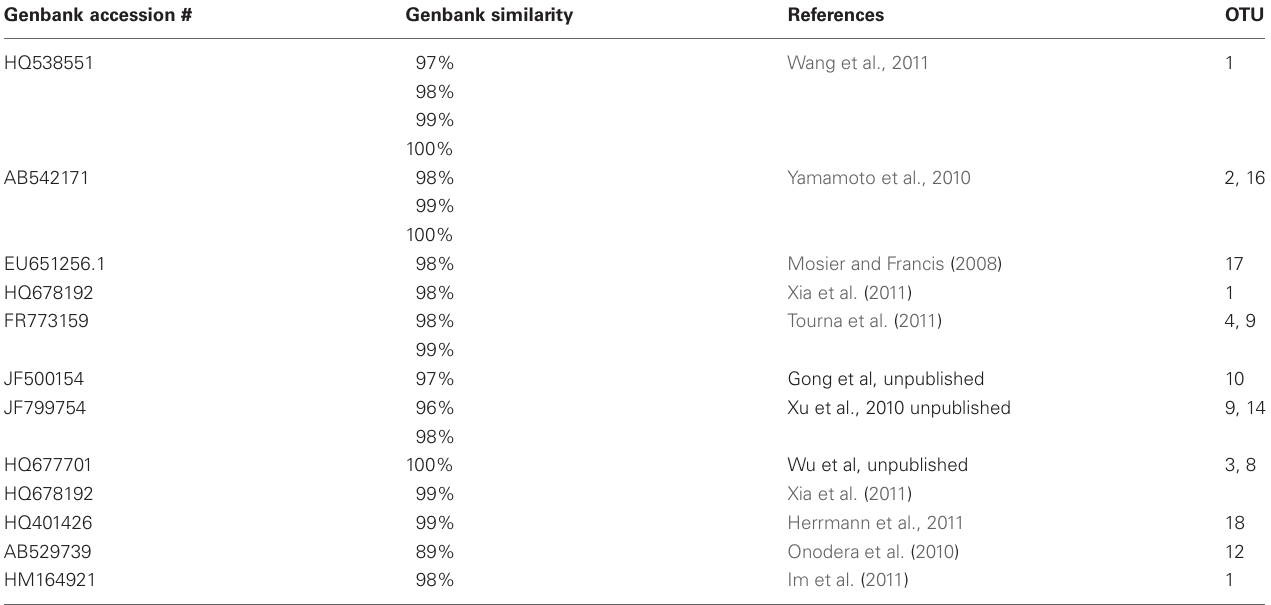
Table A4 | Genbank accession numbers and similarity to mature sequences and